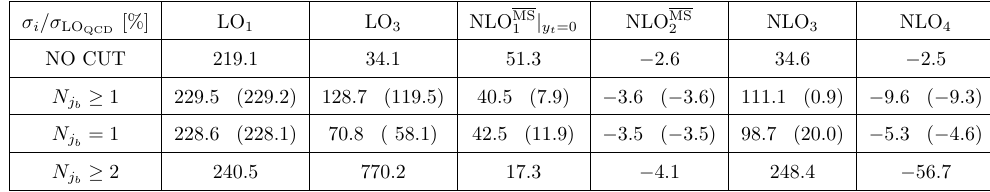
Ratio with the LO QCD contribution for the LO 1 prediction and for each perturbative order entering the complete-NLO predictions ( NLO all ). Numbers are in percentage and those in parentheses are obtained by vetoing light jets. Details are explained in the text.